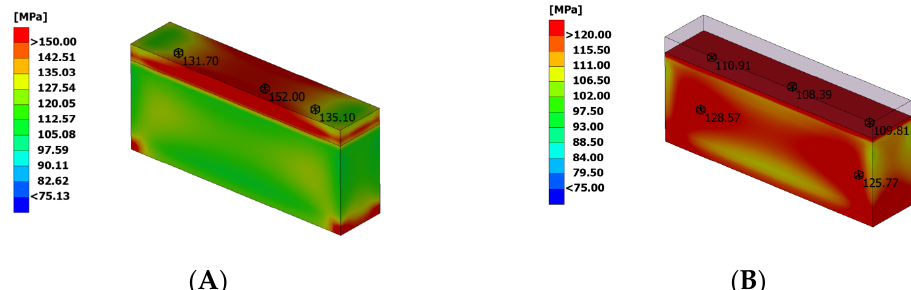
Figure 15. The experiment calibration result. ( A ) Stress concentration on the surface layer of spraying;